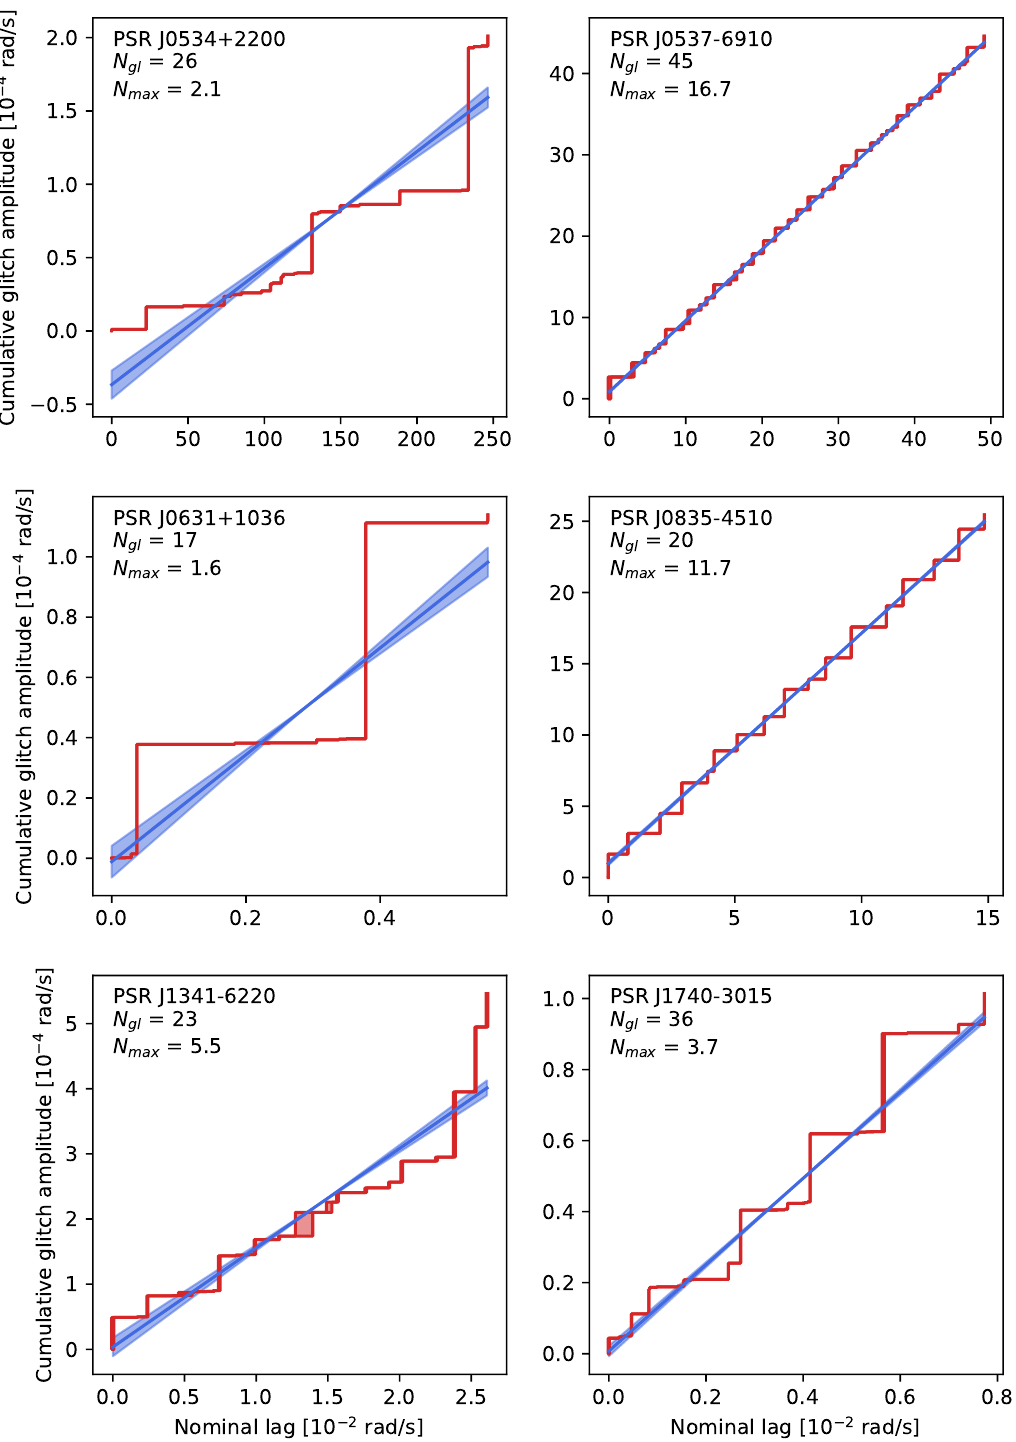
Figure 1. The glitch steps drawn by the cumulative points ( | ˙ Ω ∞ | t i , Ω i ) , defined in (4), for the six pulsars with the largest number of glitches N gl , as reported by the Jodrell Bank Glitch Catalogue [8]. The activity is calculated with a least-squares linear fit on the midpoints of the cumulative glitch sequence (see [42]), giving the blue curve with the associated uncertainty on the slope. Following Montoli et al. [26], the plots are made by using the “nominal lag” t | ˙ Ω ∞ | on the horizontal axis (a rescaling of time t , which gives a rough estimate of the typical angular velocity lag accumulated between the spinning down normal component and a pinned superfluid component). In this way, the slope of the blue curves is the dimensionless activity G